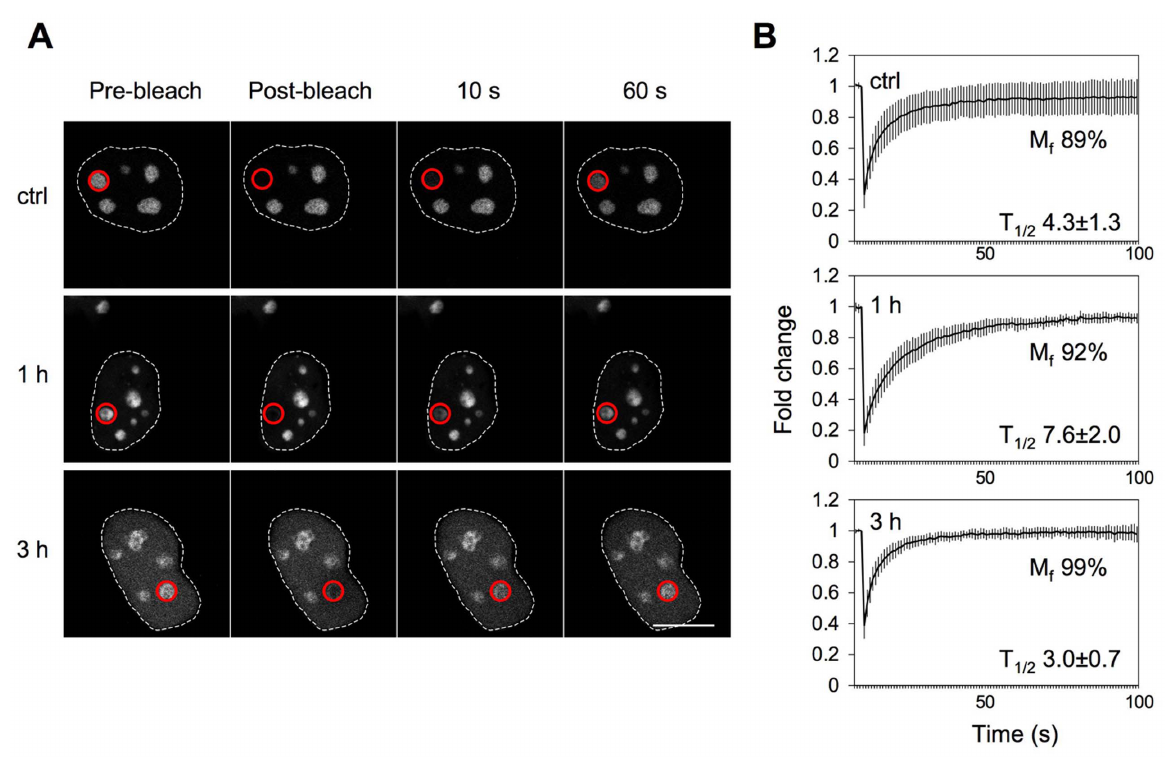
Figure 1. NPM nucleolar mobility is increased following UV radiation. A U2OS cells were transiently transfected with NPM-ECGFP and treated with UVC (35 J/m 2 ) or left untreated (control). FRAP analysis was performed on a single nucleolus as indicated by ROI ( red circle). Following photobleaching images were captured every 1 s for 100 s. Representative images are shown. Scale bar 10 m m. B Averages of normalized intensities, mobile fraction (M f ) and recovery half times (T 1/2 ) from at least two independent experiments for each treatment are shown. Error bars, SD. N $ 8 cells for each